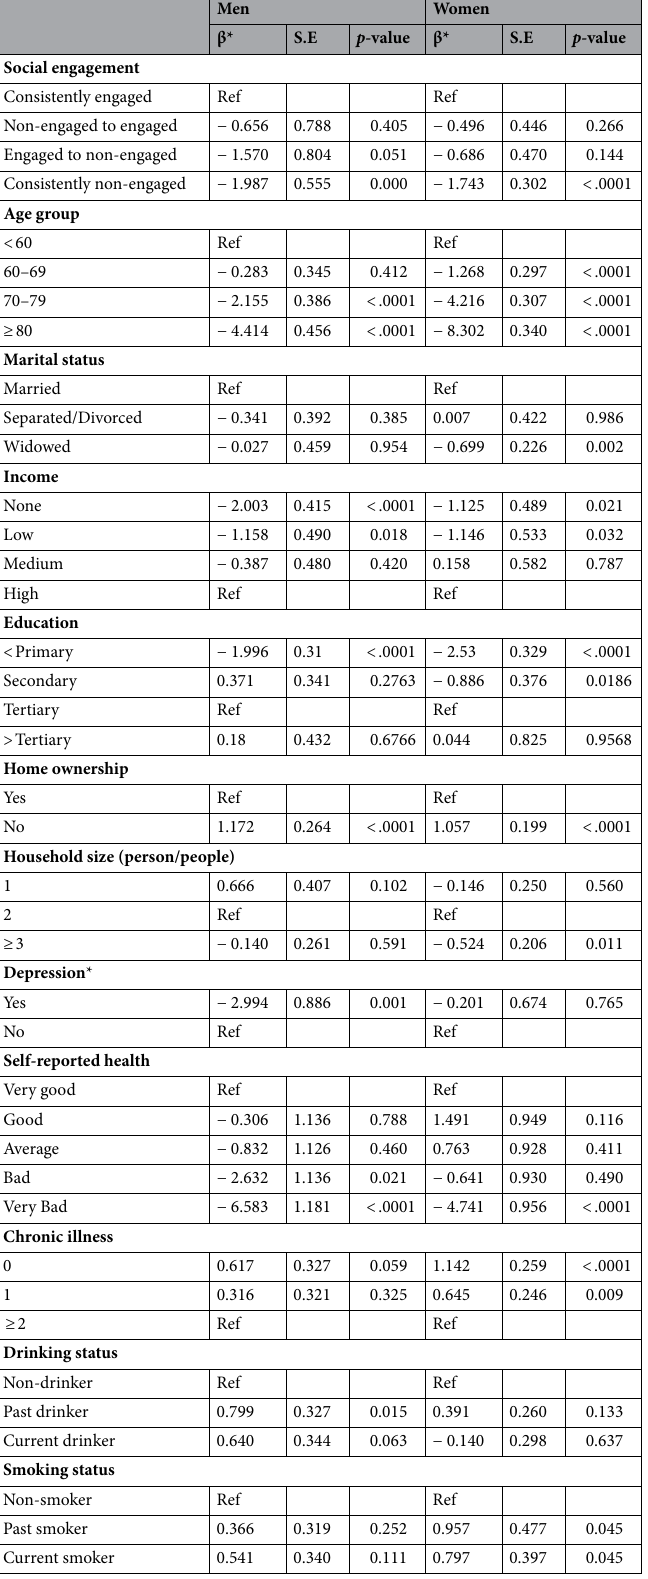
Table 2. GEE analysis of association between social engagement and cognitive decline measured via K-MMSE. *Sum of CESD-10 ≥ 10 (Lee et al.